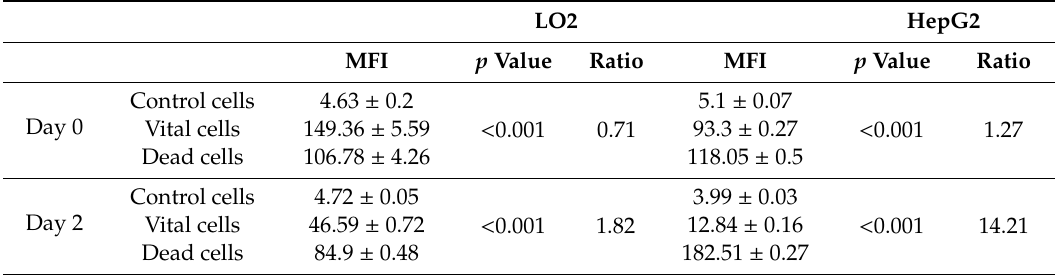
Table 1. The mean fluorescence intensity (MFI) of Hyp by flow-cytometric analysis in LO2 or HepG2 cells at early and late stages: The results are expressed as the mean ± standard error (N = 3, Student’s t test). Ratio: the ratio of MFI in dead cells to that in vital